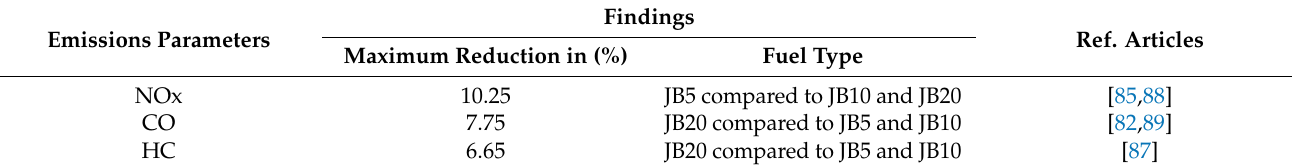
Table 7. Finding of emissions for JB blends and diesel fuels.